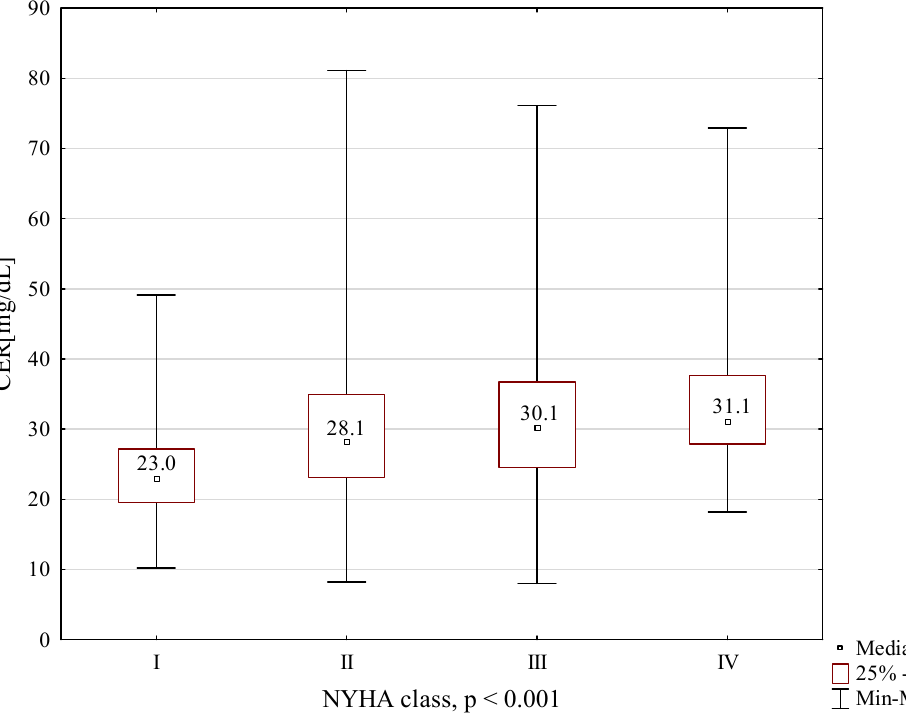
Figure 1. CER concentration in subgroups depending on NYHA classification.